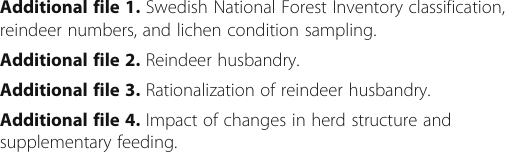
Additional file 1. Swedish National Forest Inventory classification, reindeer numbers, and lichen condition sampling. Additional file 2. Reindeer